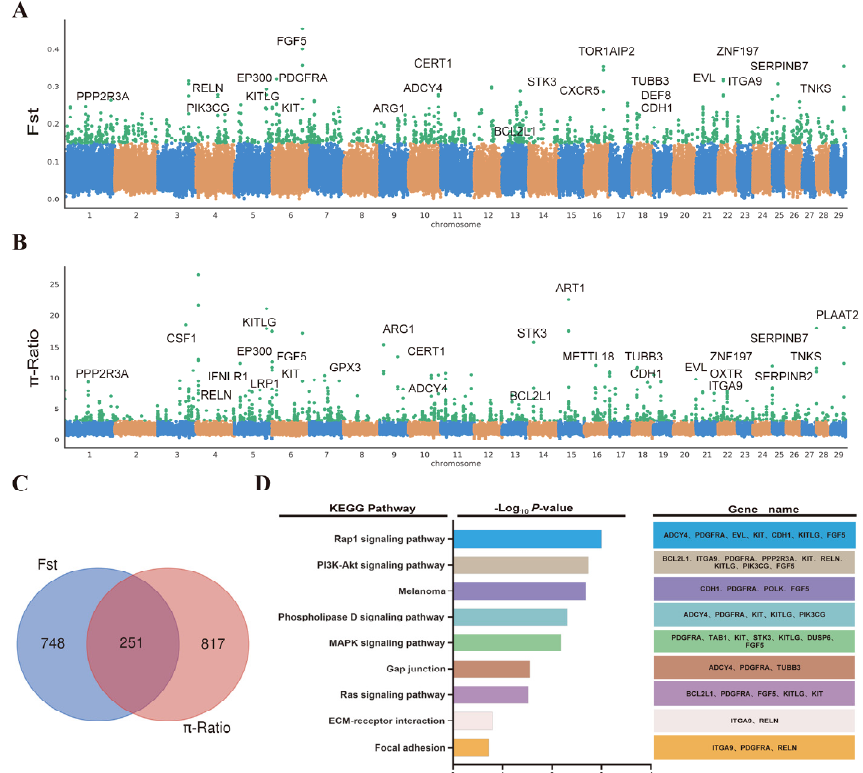
Figure 4. Genome − wide selection sweep for candidate genes in cashmere goats using sliding window analysis. ( A ) Selection signatures in cashmere goats for Fst . ( B ) Selection signatures in cashmere goats for π -Ratio. The values were calculated in 50-kb sliding window with 20-kb step across all autosomes, and top 1% values are marked with a green dot. ( C ) The number of shared candidate genes in cashmere goats by two methods. ( D ) KEGG enrichment analysis for the shared candidate